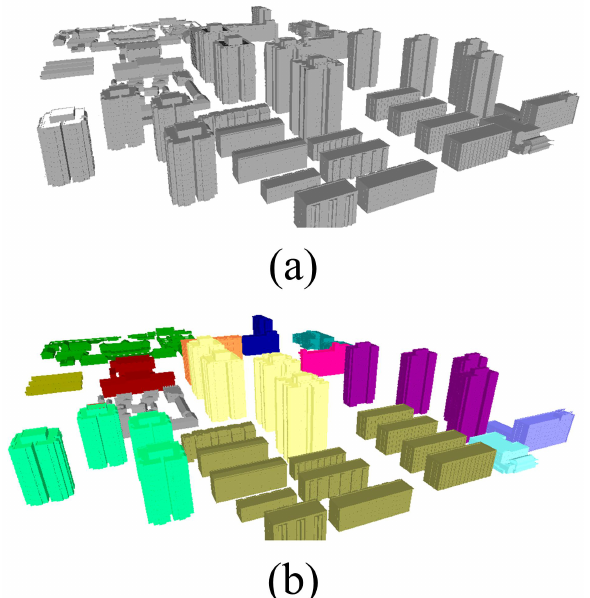
Figure 3. Subarea determination among building models. (a) The geometric building models in certain city zone. (b) The building models grouped according to their structure